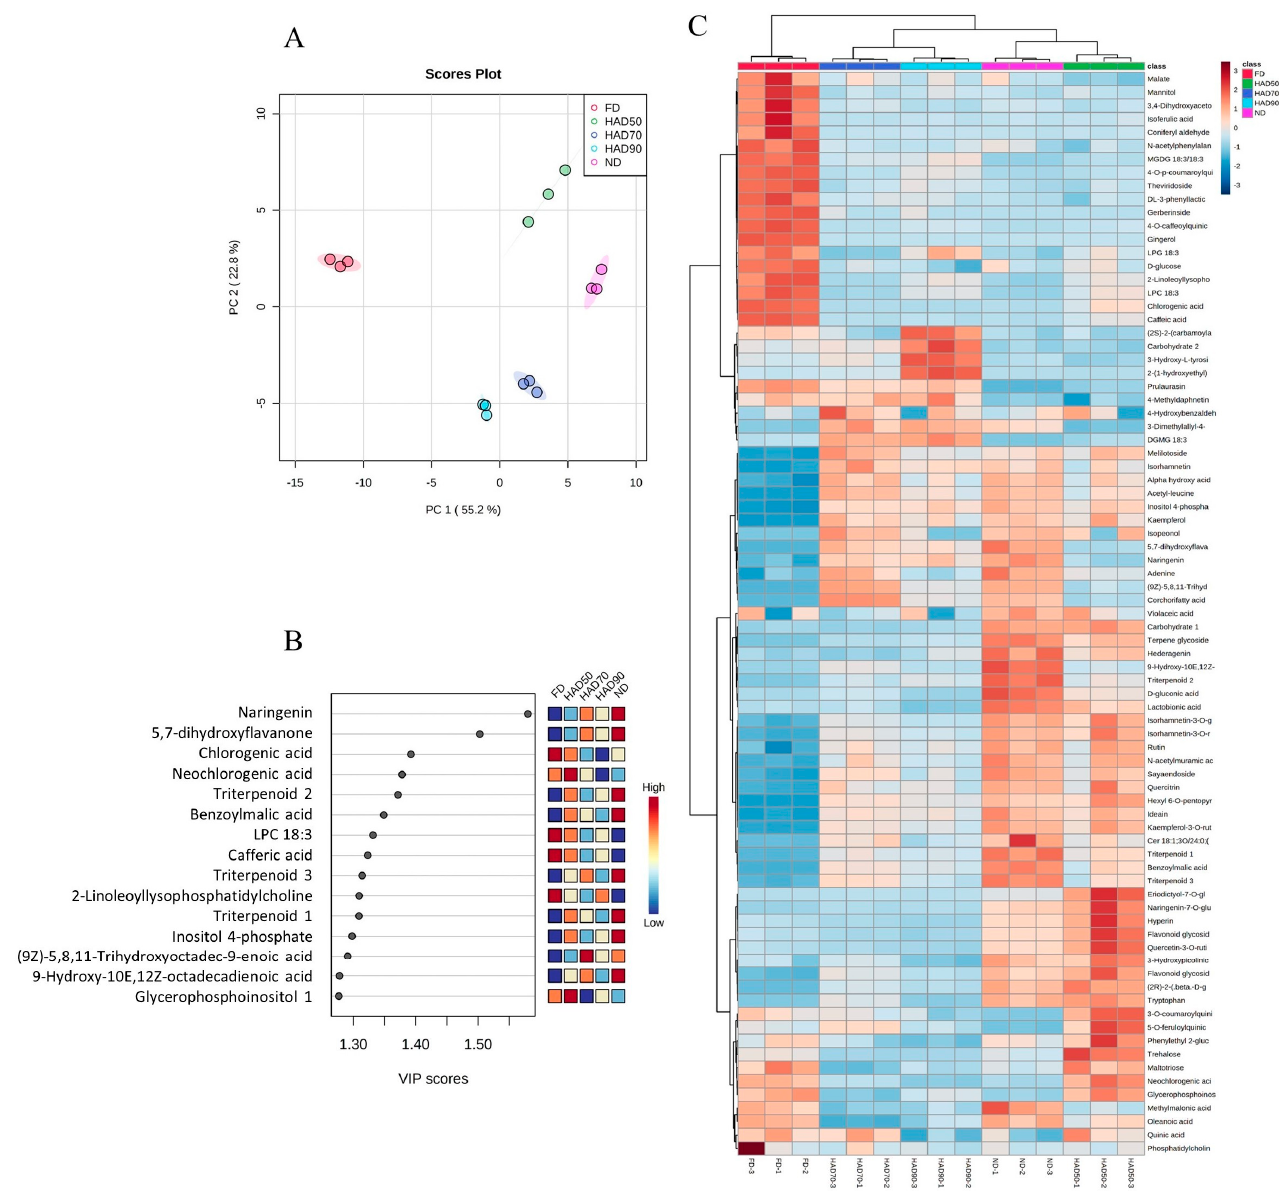
Figure 1. Multivariate statistical analysis showing the projection of metabolites from thinned peach extracts: ( A ) principal component analysis (PCA); ( B ) partial least squares discriminant analysis (PLS-DA); ( C ) HeatMap.